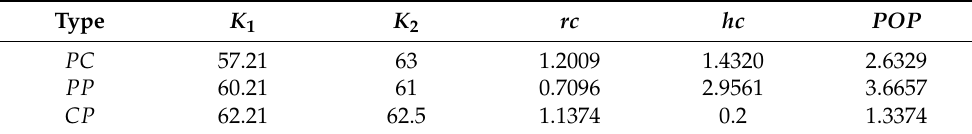
Table 8. Other product